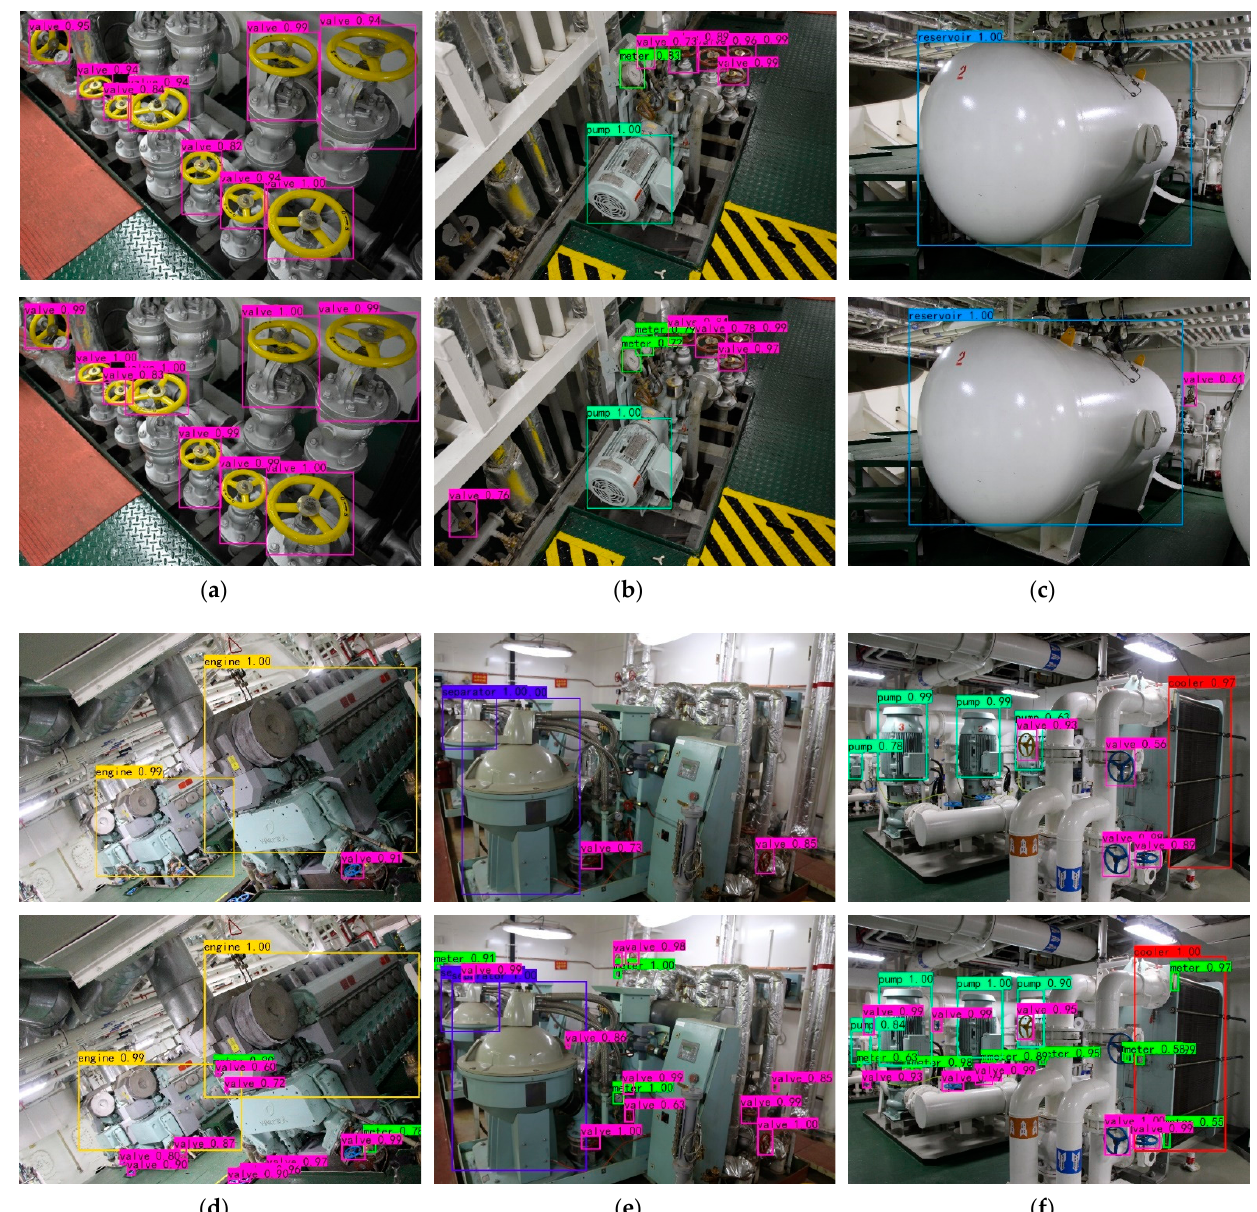
Figure 10. Detection results visualization on AEMER dataset. In column ( a ) we present the auxiliary equipment of valves. In other columns, we present the equipment of pumps ( b ), meters ( b ), reservoirs ( c ), auxiliary engines ( d ), coolers ( f ), and oil separators ( e ). In six of the comparisons, the upper images are the output of the original RetinaNet and the lower images are the output of the proposed RepVGG-RetinaNet.